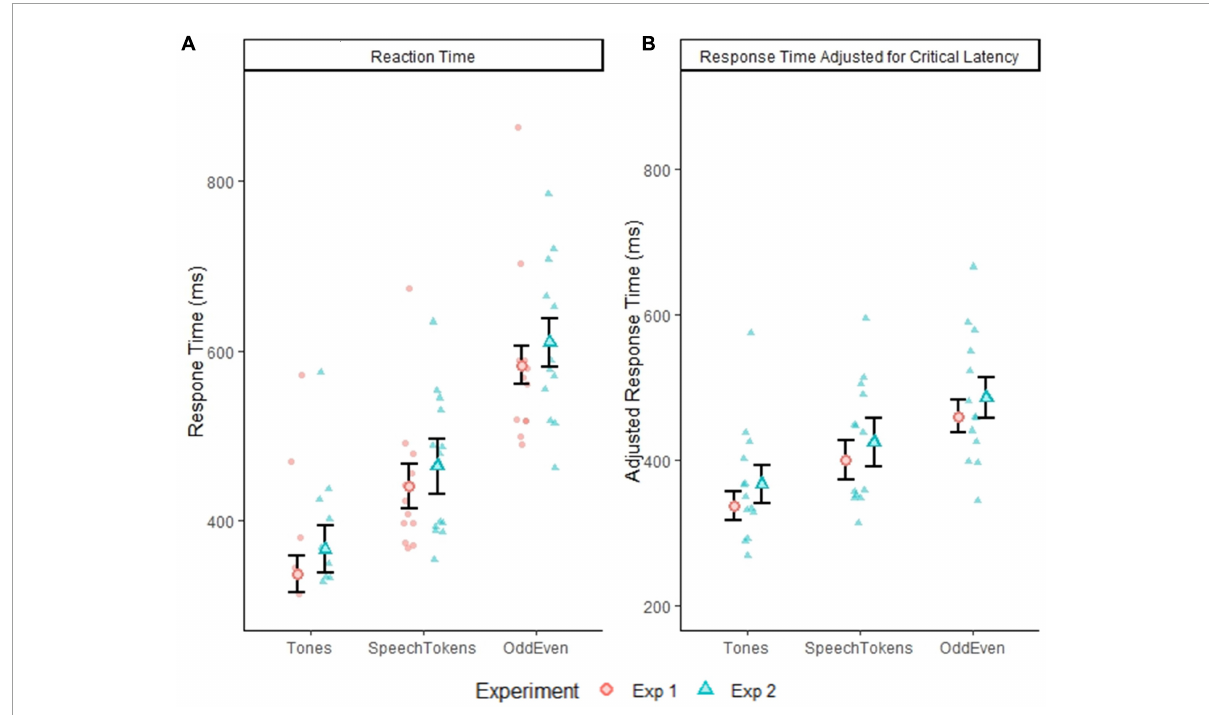
FIGURE2 (A) Depicts the group average reaction time with within subject error bars for all three tasks from experiment 1 and 2. (B) Depicts the group average reaction time adjusted for critical latency. Error bars reflect standard error of the mean. The smaller faded red circles (Experiment 1) and smaller faded blue triangles (Experiment 2) represent the individual subject averages for each task.